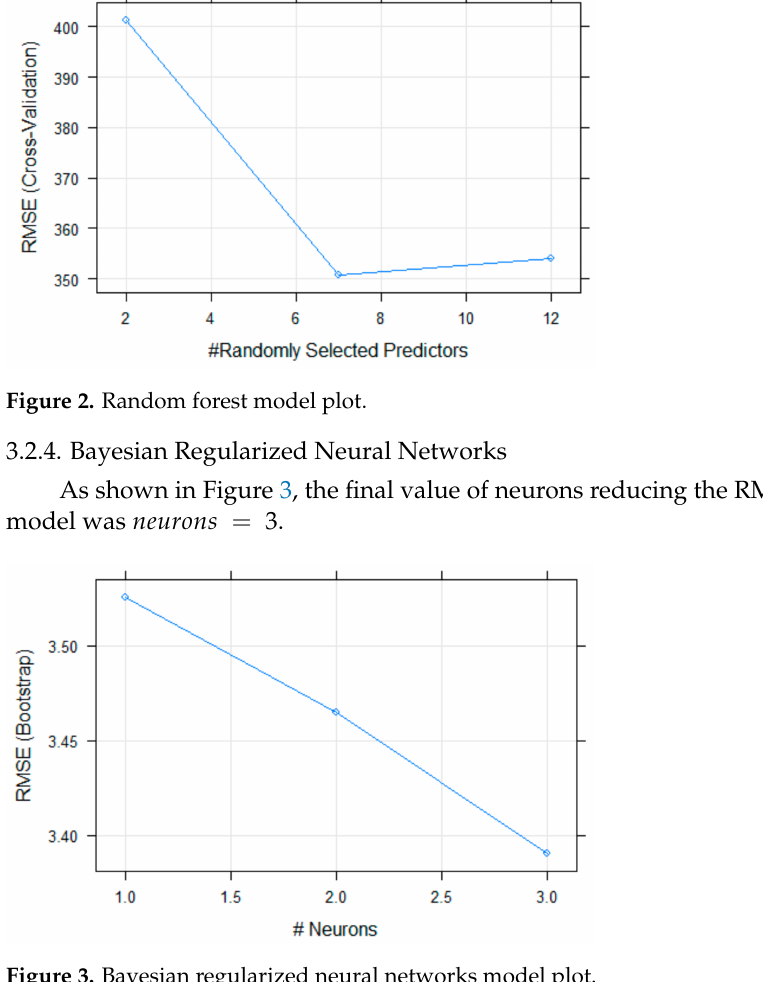
Figure 3. Bayesian regularized neural networks model plot.